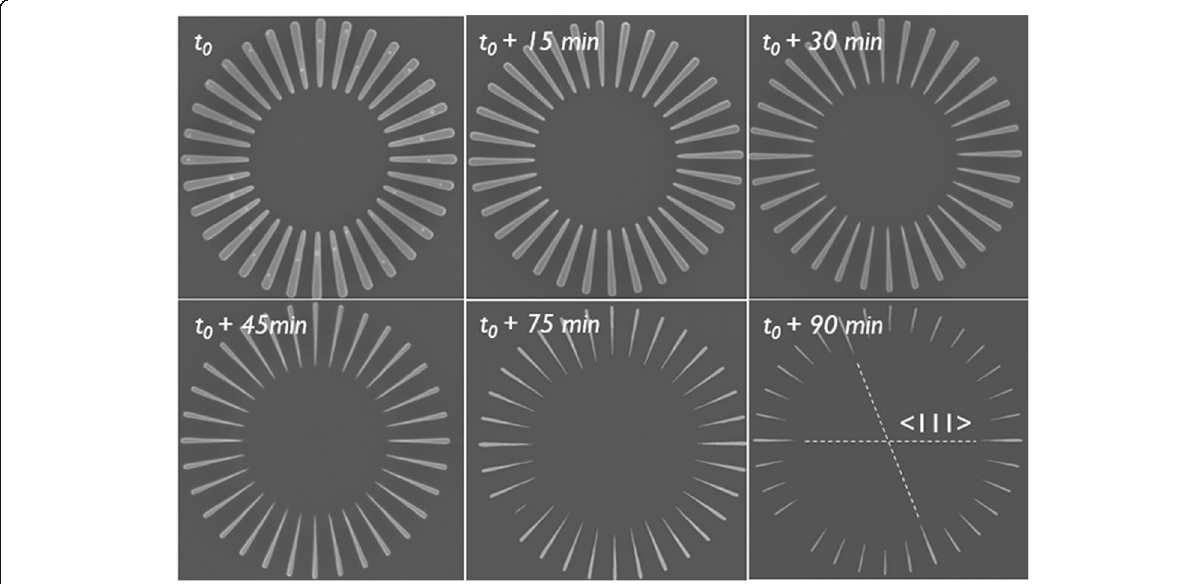
Fig. 8 Etching time series of Si(110) wagon-wheels in PAA-solution. Note the slightly slower etch rate of the <111> spokes compared to the other directions, most discernible in the image t 0 + 90 min, and indicated by the dashed